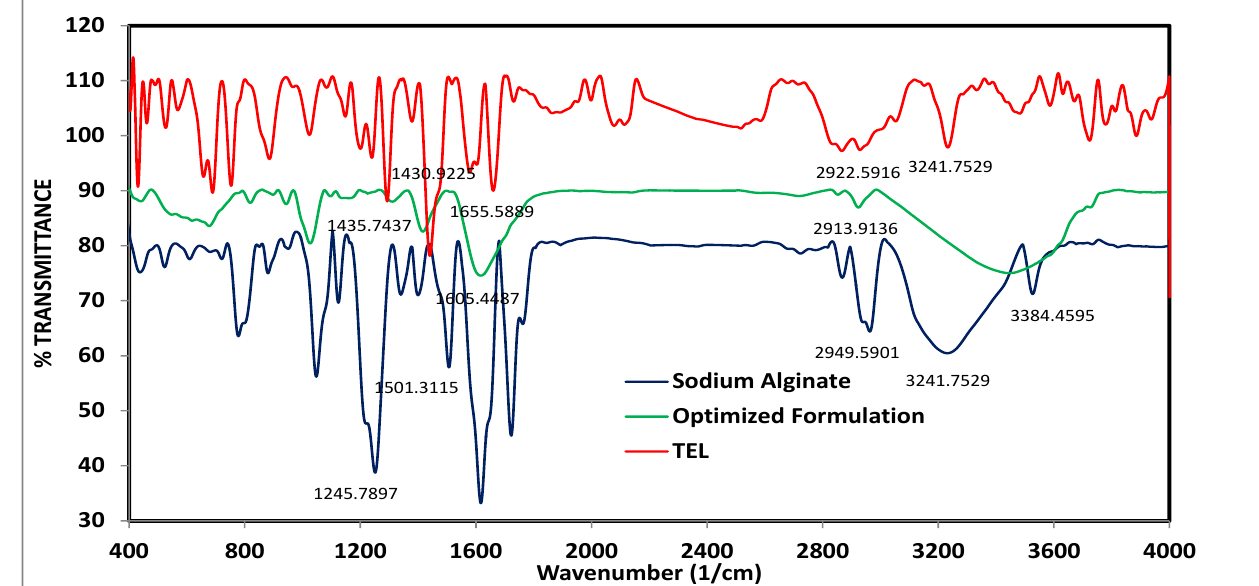
Figure 11. The IR spectra of TEL, sodium alginate, and the optimized formulation.